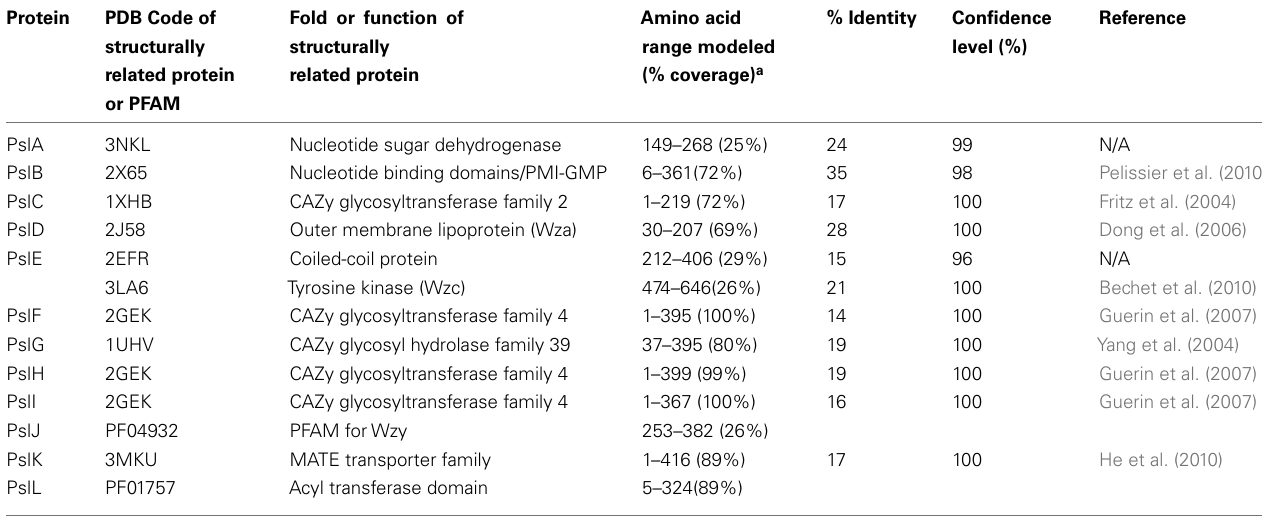
Table 3 | Structural predictions of Psl biosynthetic